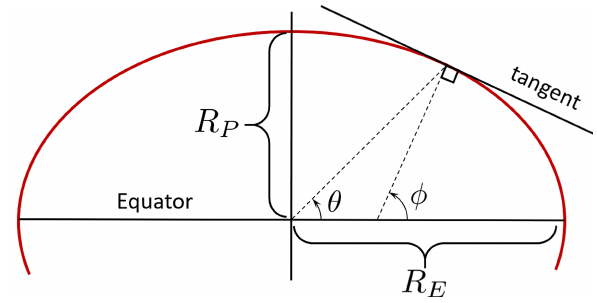
Figure 6. Geocentric ( θ ) and geodetic ( φ ) latitude angles.